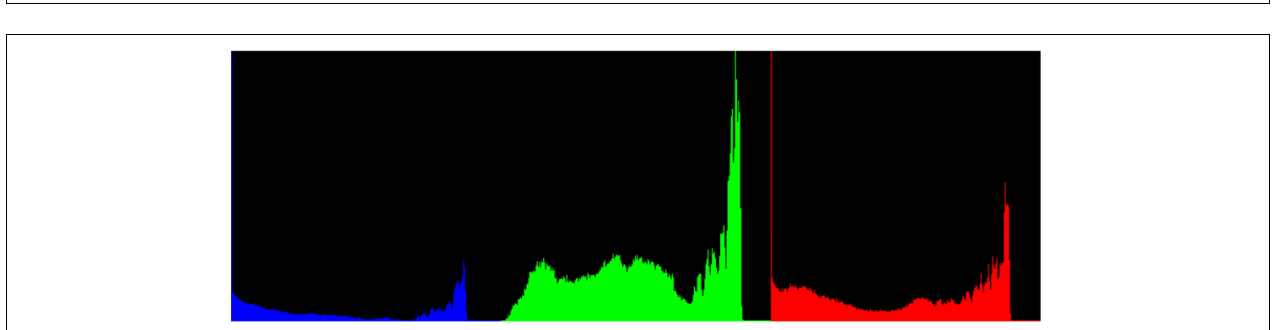
FIGURE 5 | The Image-1 and Image-2.